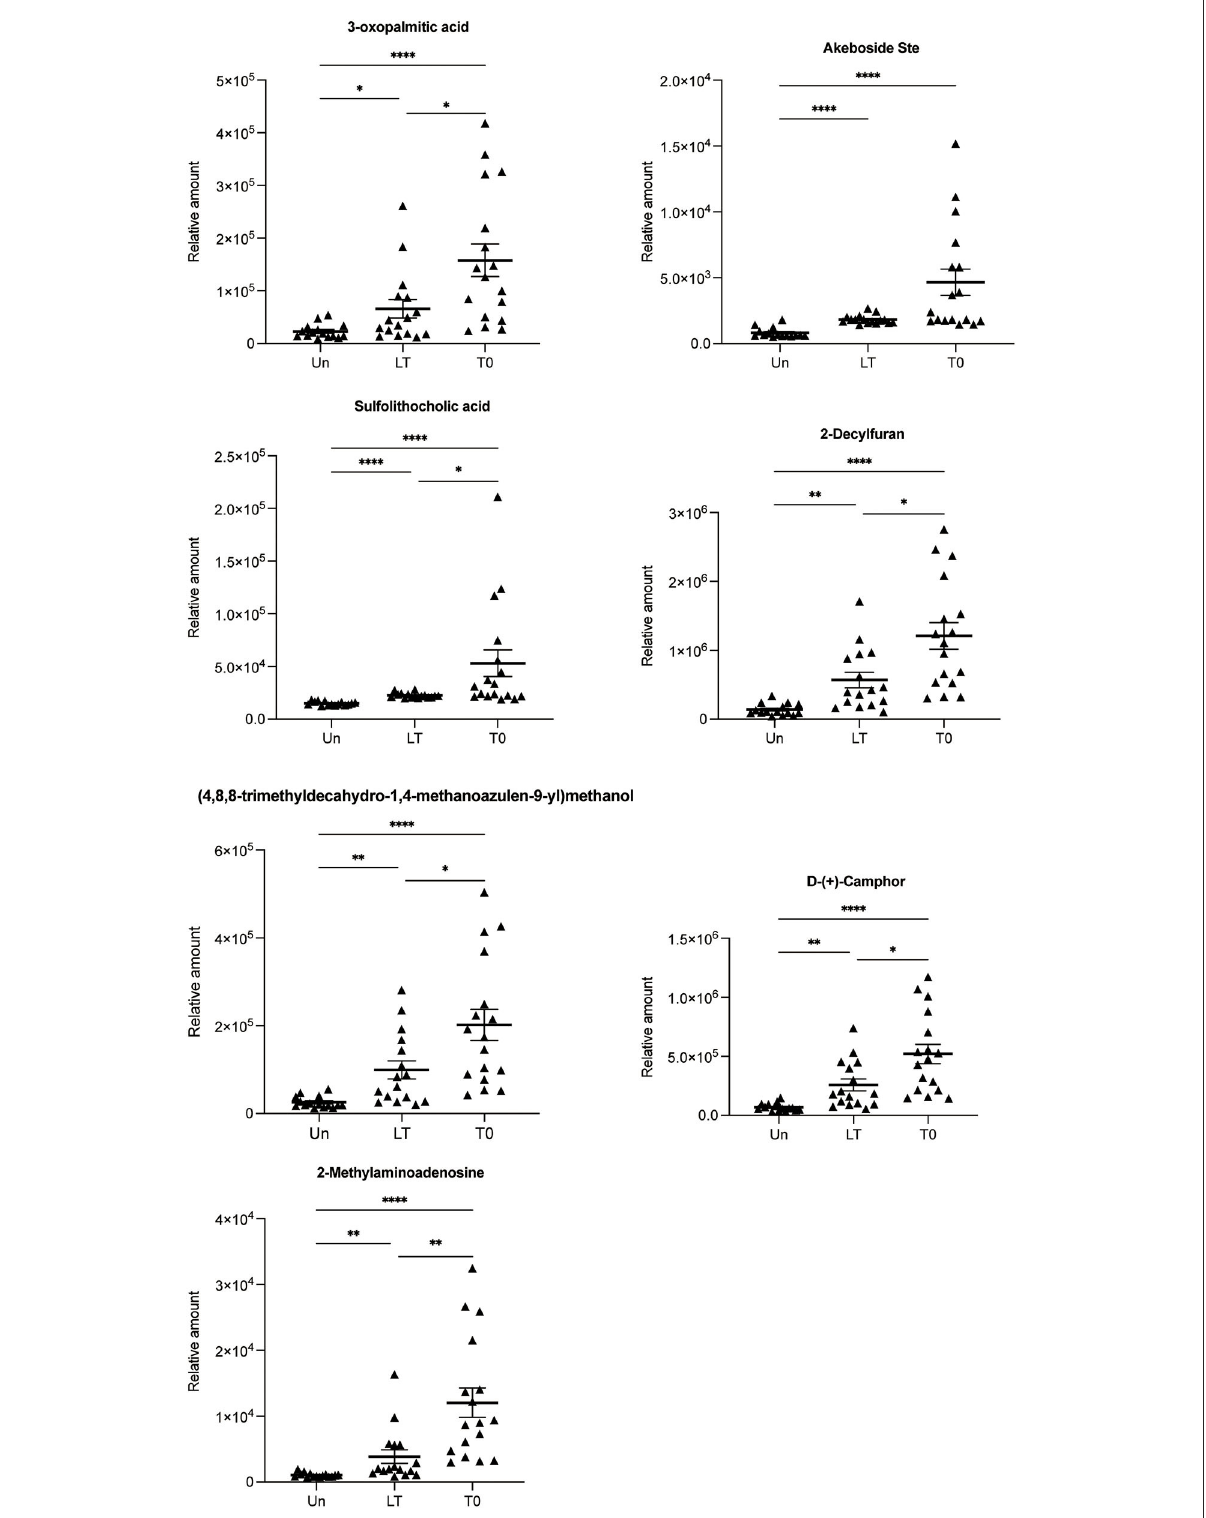
FIGURE3 Relative abundance of seven differential metabolites 3-oxopalmitic acid, akeboside ste, sulfolithocholic acid, 2-decylfuran, (4,8,8-trimethyldecahydro-1,4-methanoazulen-9-yl) methanol, d-( + )-camphor, and 2-methylaminoadenosine. The relative abundance of each metabolite in the serum from the untreated PTB (T0) and latent tuberculosis infection (LT) was significantly higher than that of the healthy control (Un) using the Kruskal–Wallis test and corrected for multiple comparisons by controlling the False Discovery Rate. * q < 0.05; ** q < 0.01; **** q <